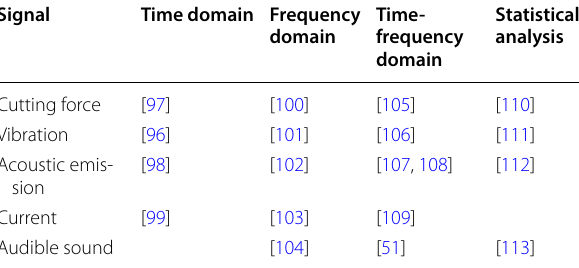
Table 5 Processing methods for different manufacturing signals